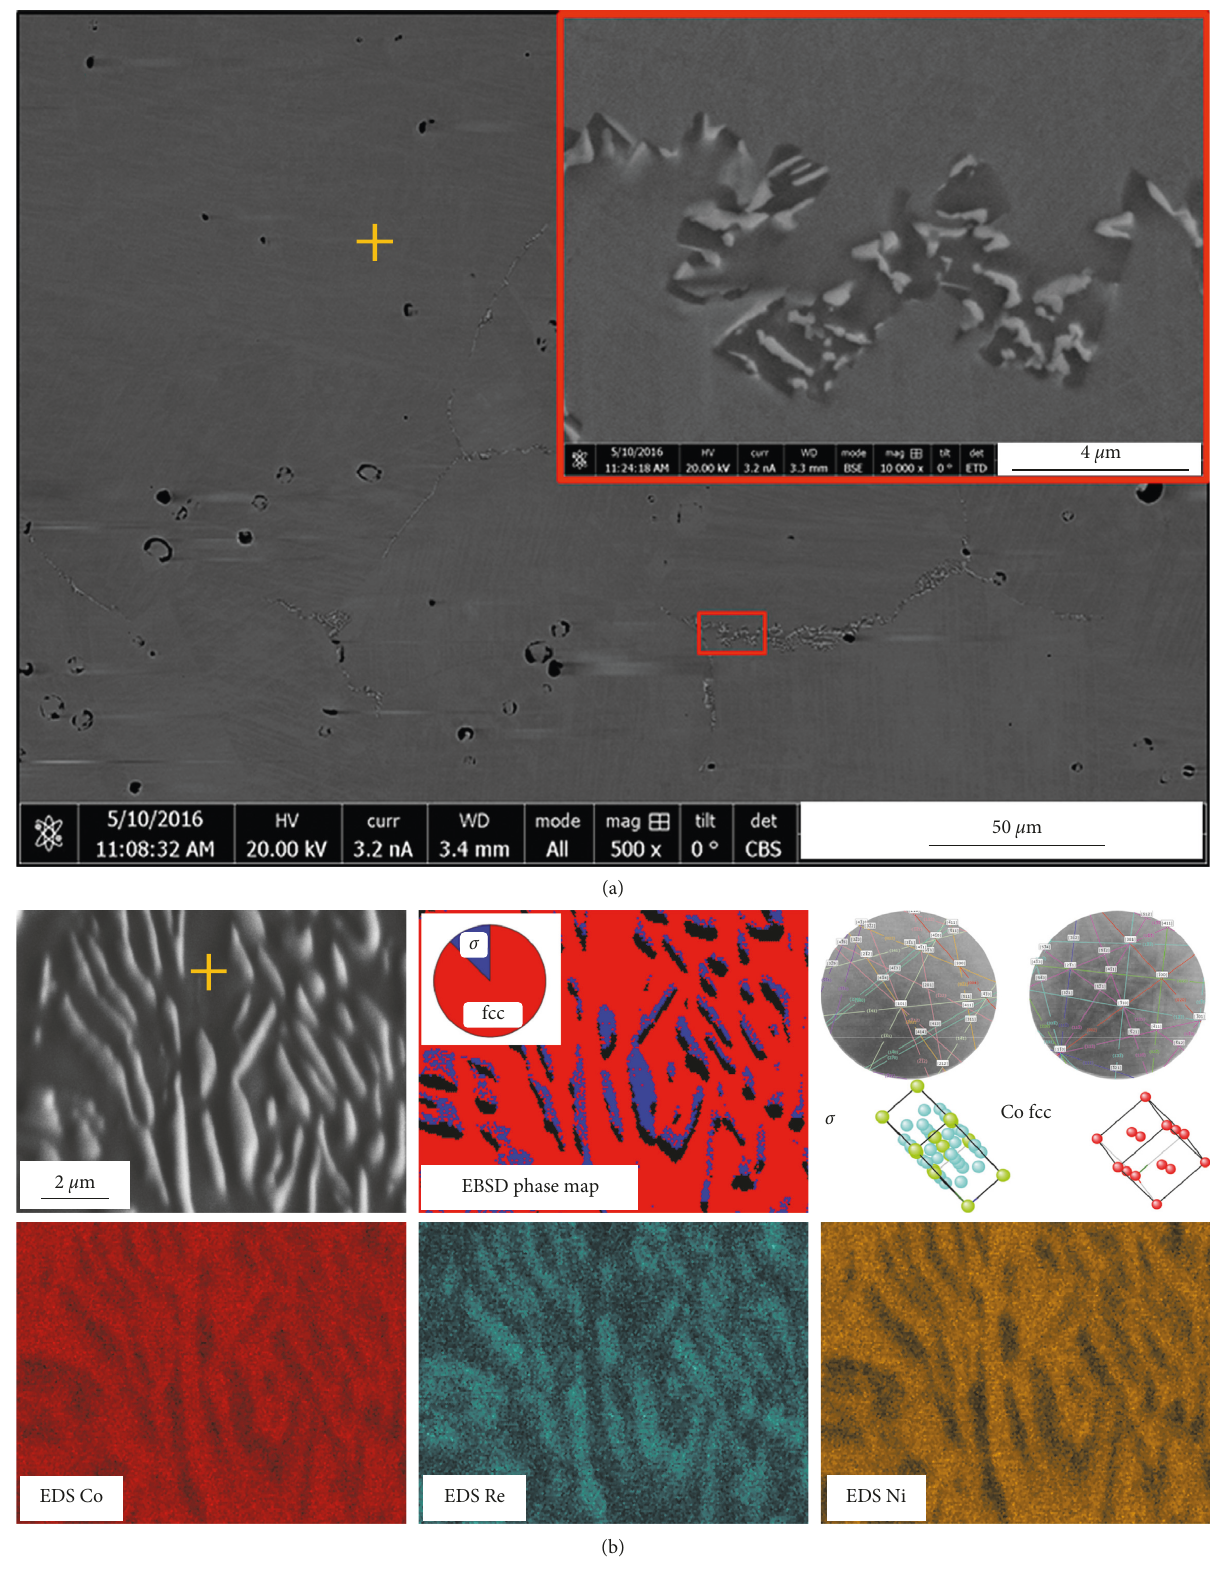
Figure 4: Micrograph of the Co-Re-23Cr-25Ni alloy showing the formation of the σ phase (a) at grain boundaries in ST condition and (b) within grains after 800 ° C (100h) exposure. The EBSD phase map and EDS elemental distribution are also shown. Compositions were determined by EDS at cross marked positions in (a) and (b), and results are listed in Table